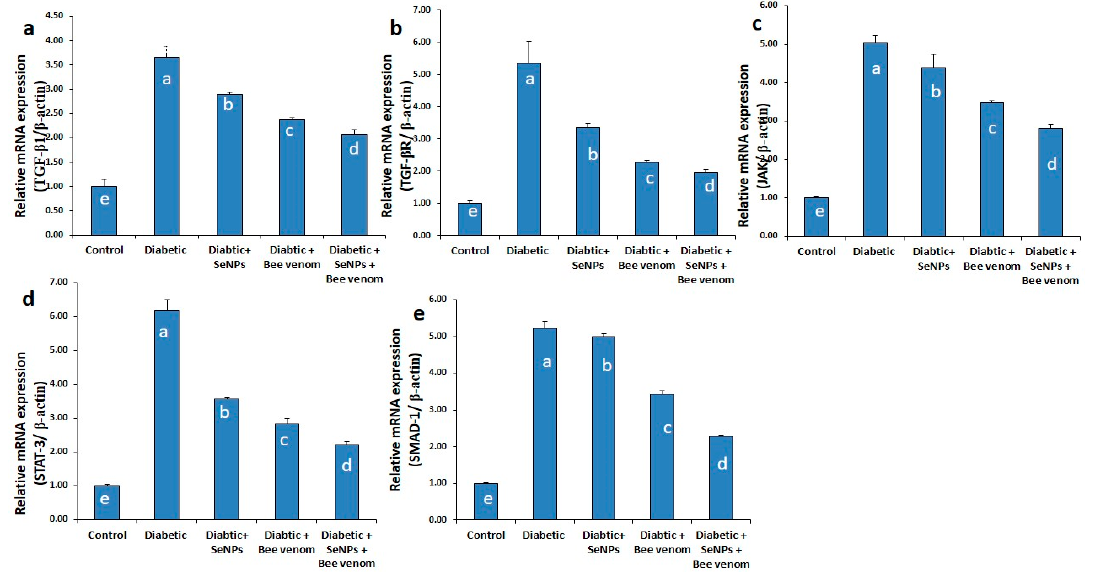
Figure 3. The expression levels of TGF- β 1 ( a ), TGF- β R ( b ), JAK-1 ( c ), STAT-3 ( d ) and SMAD-1 ( e ) genes in cardiac tissues of normal and STZ-diabetic rats.